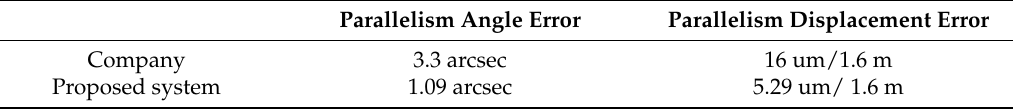
Figure 23. Case 4 parallelism error measurement setup. Table 9. The parallelism error measurement results. Parallelism Angle Error